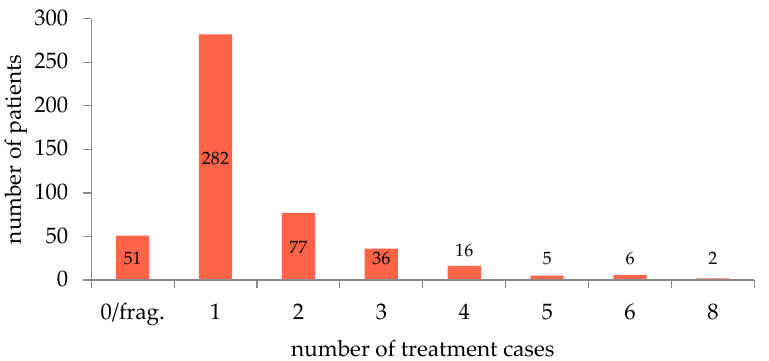
Figure 1. Frequency of treatment cases for dental care. Most patients had only one treatment case.